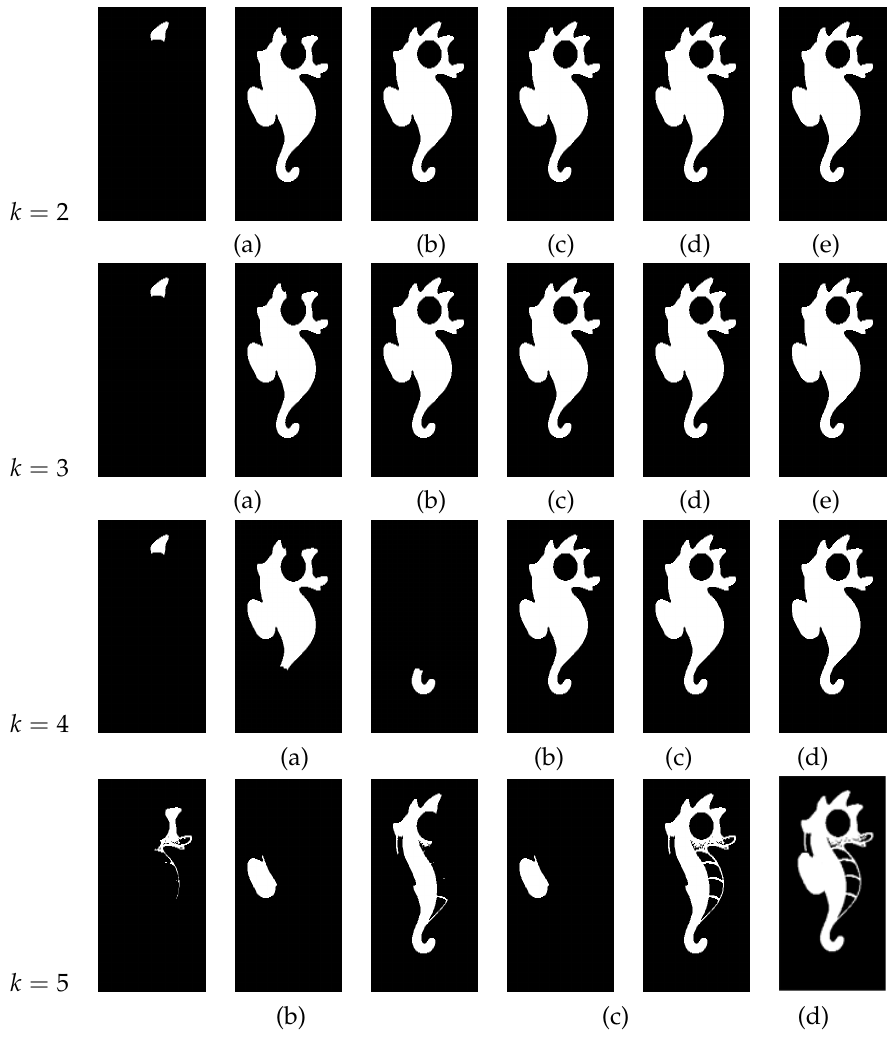
Figure 20. Extracted regions for different values of d ( a ) d = 25; ( b ) d = 30; ( c ) d = 40; ( d ) d = 45; ( e ) d = 50.